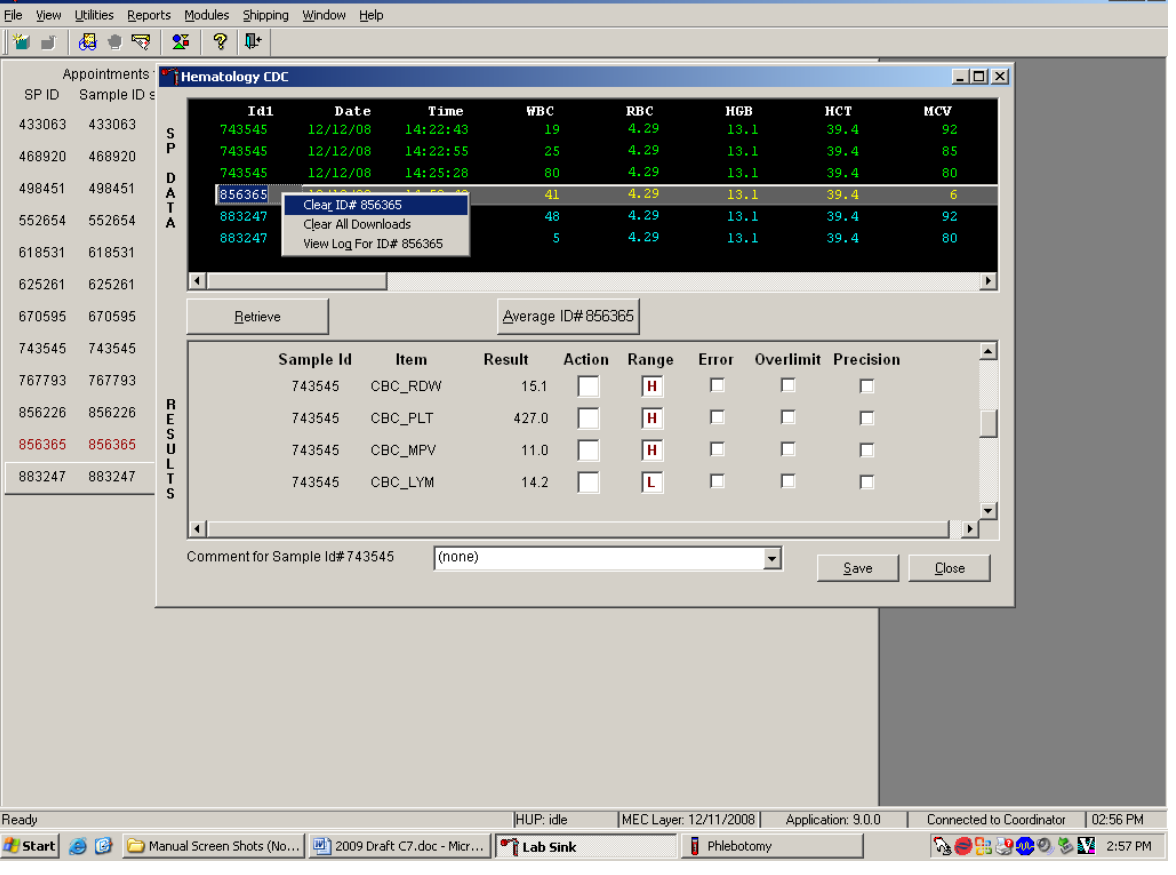
To clear the Coulter downloads for any one SP, use the mouse to direct the mouse arrow to the individual row in the SP Data section, right click to display the alternative data manipulation choices, drag the mouse arrow to {Clear ID# XXXXXX }, and right or left click or type [Shift] [R/r]. Release the mouse button to clear this download. Retransmit, retrieve, average, and save the